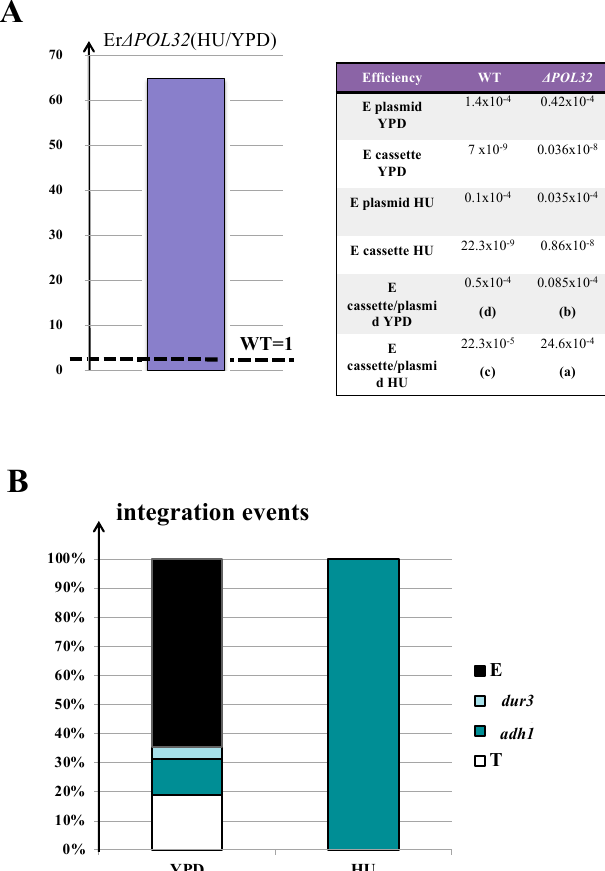
Figure 6. Analysis of the ∆ POL32 mutant. ( A ) The graphic on the left side was plotted using the data included in the table on the right. On the y-axis, the relative efficiency of the ∆ POL32 mutant respect to wild type (normalized to 1) is reported. The efficiency of transformation with the AD cassette of the mutant blocked in S phase (indicated as “a” in the table of Figure 6A) was divided by its own transformation efficiency with the same cassette in an asynchronous population (b, table in Figure 6A). Then, the efficiency of transformation with the AD cassette of the wild type blocked in S phase (c, table of Figure 6A) was divided by its own transformation efficiency in an asynchronous population (d, table of Figure 6A). The efficiencies with the linear cassettes were related to the transformability of each strain with the plasmid YCp50 in the same experimental conditions. Therefore, the bar reported in Figure 6A was obtained dividing a/b by c/d and represents the efficiency of transformability (Er) of the ∆ POL32 mutant with the AD cassette in S phase with respect to its own transformability in the asynchronous state and then normalized to the wild type. The raw data and statistical significance are reported in Table S2C. ( B ) The percentage distribution of the integration events of the AD cassette in the ∆ POL32 mutant. On the left: distribution of events in an asynchronous population of the mutant (YPD). On the right: the distribution of events when the mutant is blocked in S phase (HU). E: ectopic integration; T: translocants; dur3 : integration at the dur3 locus only; adh1 : integration at the adh1 locus only. Er: Relative Efficiency of transformability. The raw data for Figure 6B are reported in Table